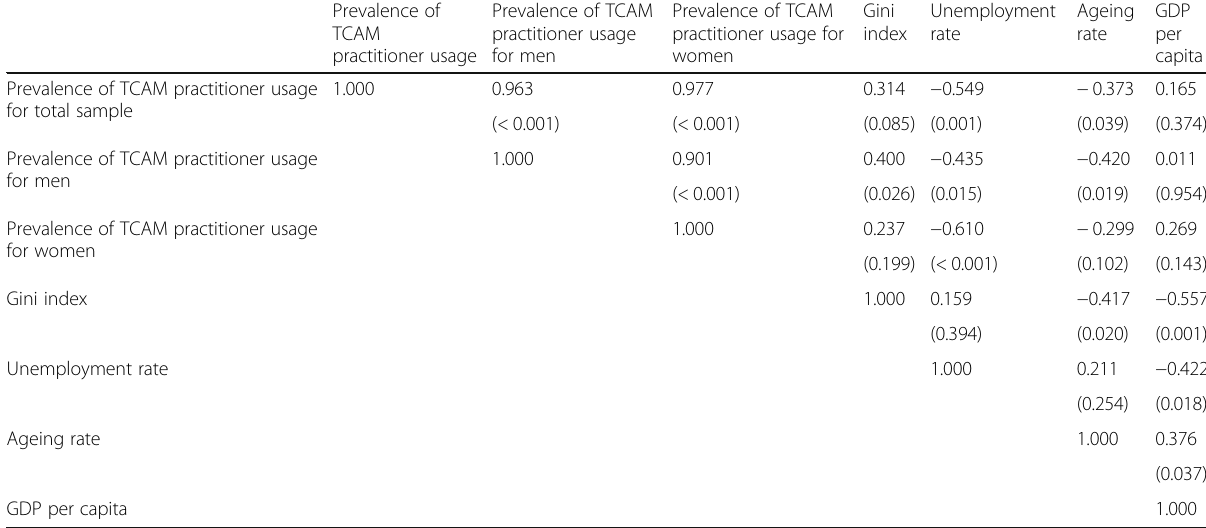
Table 3 Associations with the prevalence of TCAM practitioner usage for total sample and by gender